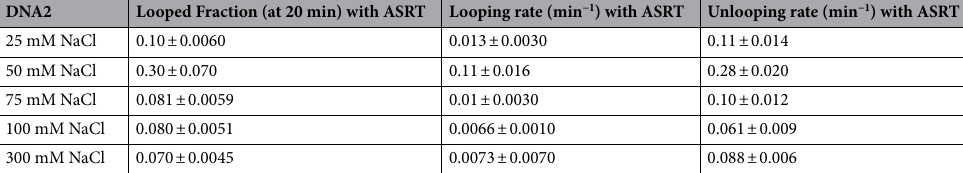
Table 3. Salt concentration dependent of DNA2-ASRT interaction.